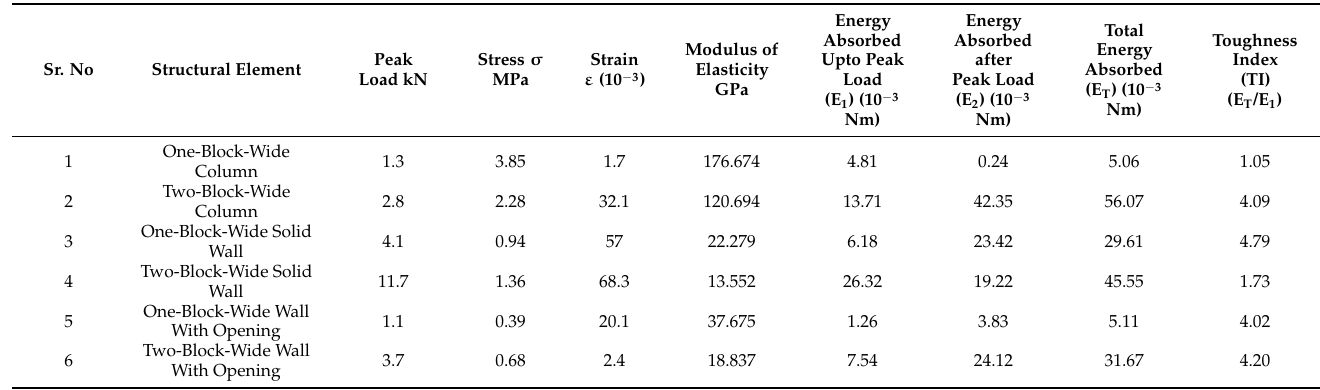
Table 2. Experimental energy absorption and toughness index values of interlocking-plastic-block structural